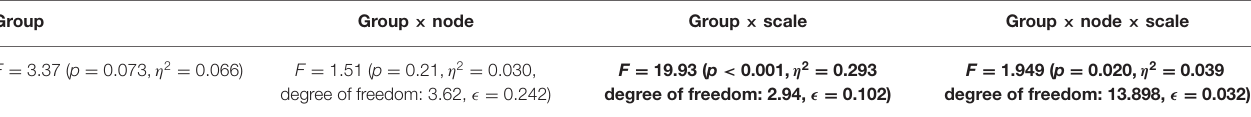
TABLE 2 | Younger vs. older repeated–measures ANOVA results [ F value ( p value, partial η 2 )], degree of freedom and Greenhouse-Geisser adjustments ǫ in multi scale entropy (MSE) analysis. Group Group × node Group × scale Group × node × scale F = 3.37 ( p = 0.073, η 2 = 0.066)